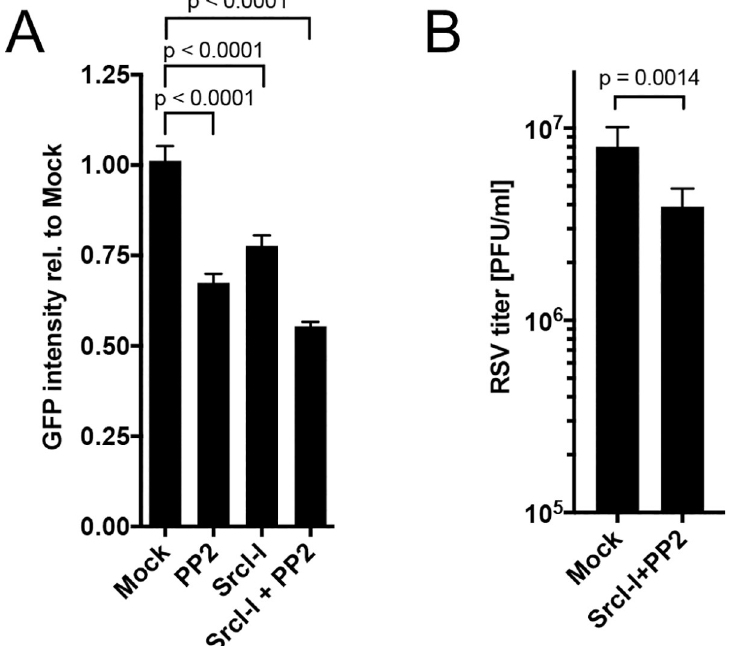
Fig 6. Src-kinase activity is required for infection. A549 cells were pre-treated with non-cytotoxic concentrations of the indicated Src-kinase inhibitors (PP2 [12.5 μ M], SrcI-I [6.25 μ M] or both) or mock-treated (DMSO carrier control) for 5 h. Cells were then inoculated with RSV-GFP (MOI = 1 PFU/cell) in media containing the indicated inhibitors. (A) Effect of Src-kinase inhibition on RSV infection. At 17 h p.i., GFP intensity was measured with an ELISA reader and expressed relative to mock-treated infected cells assigned the value of 1.0. (B) Titer of progeny RSV-GFP. At 24 h p.i. RSV titers were determined in replicate cultures by plaque titration on Vero cells. The statistical significance of the difference was determined by one-way analysis of variance with Tukey’s multiple-comparison post-test and p-values are shown for each